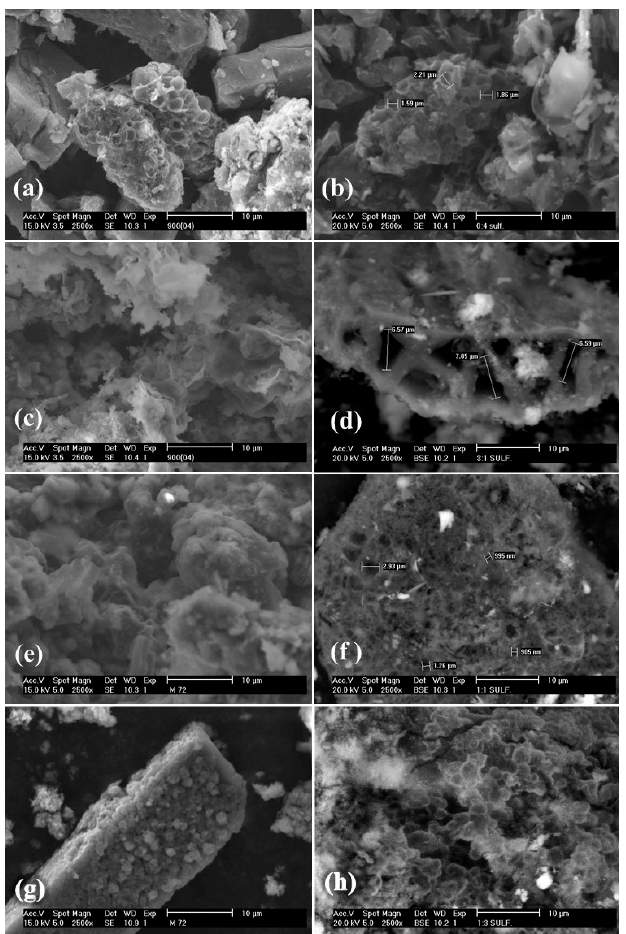
Figure 4. Micrographs of biochars obtained at 900 ◦ C: ( a ) B-100-9, ( b ) BS-100-9, ( c ) B-25-9, ( d ) BS-25-9, ( e ) B-50-9, ( f ) BS-50-9, ( g ) B-75-9, ( h ) BS-75-9.